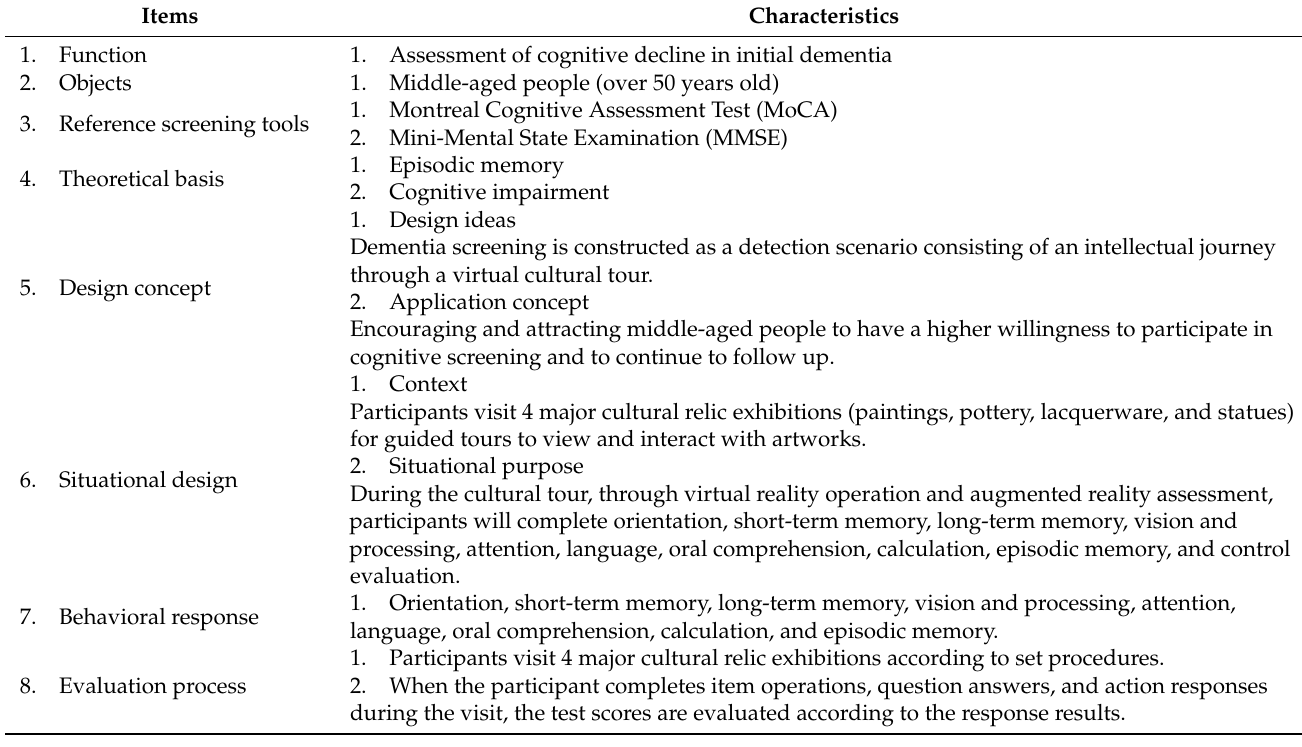
Table 1. Characteristics of the VSIDCS.